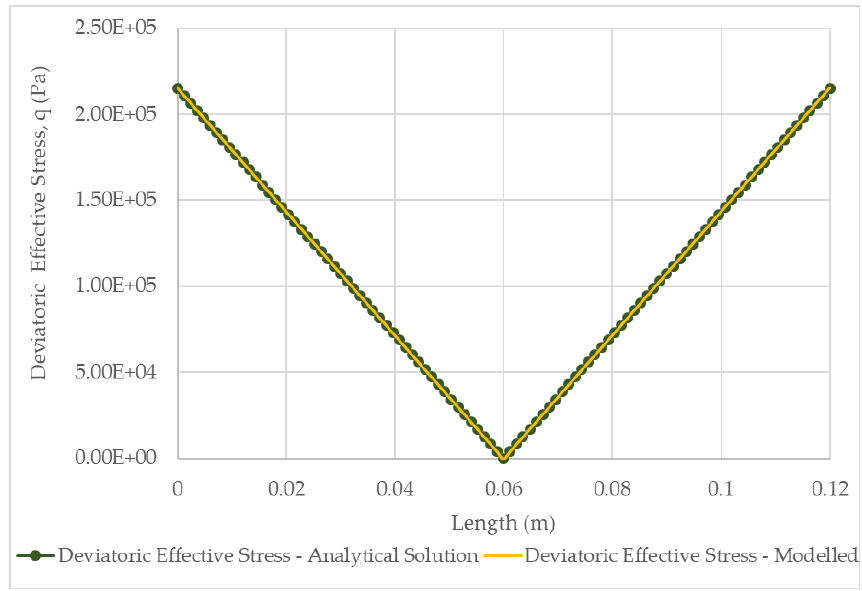
Figure 6. Verification study — 1D steady-state solution results for deviatoric effective stress, over the length of the specimen. length of the